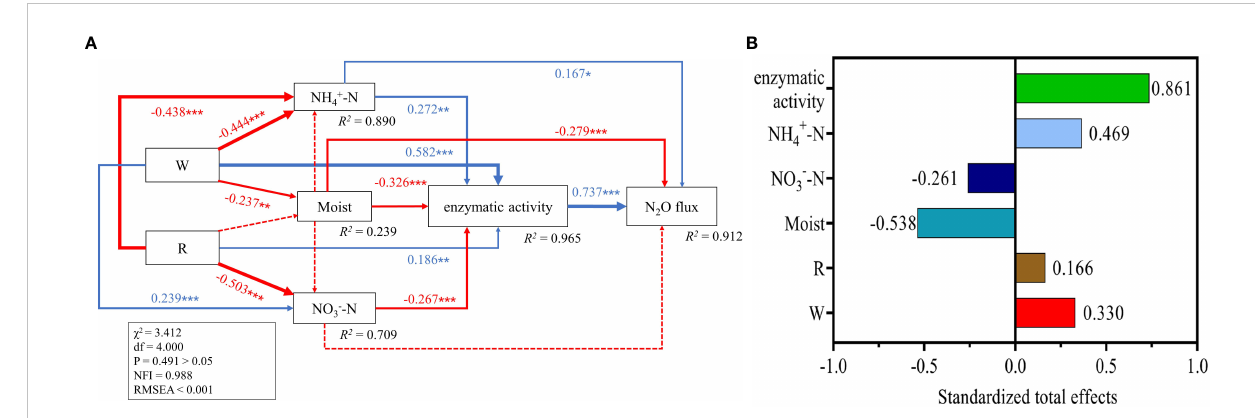
FIGURE 6 Direct and indirect effects of warming (W) and reclamation (R) on N 2 O emission fl ux (A) . W, warming; R, reclamation, NH + 4 − N : soil ammonium concentration, NO − 3 N : soil nitrate concentration, Moist: soil volumetric moisture, enzymatic activity: the fi rst principal component of PCA analysis for the activities of AMO, HAO, NXR, NOR and NOS. The arrows ’ numbers correspond to path coef fi cients. Bene fi cial and detrimental correlations are denoted by blue and red arrows, respectively. At the bottom right of boxes, the related R square in the model were displayed. “ * ” tells p < 0.05, “ ** ” tells p < 0.01, and “ *** ” tells p< 0.001. Standardized total effects (B) were showed to evaluate the effects of W, R, Moist, NH + 4 − N , NO − 3 N and enzymatic activity on N 2 O fl ux in the model, and the plus or minus of these values represented their positive or negative effects respectively on N 2 O fl ux. The information presented here includes all data gathered throughout treatments and years (n = 32).